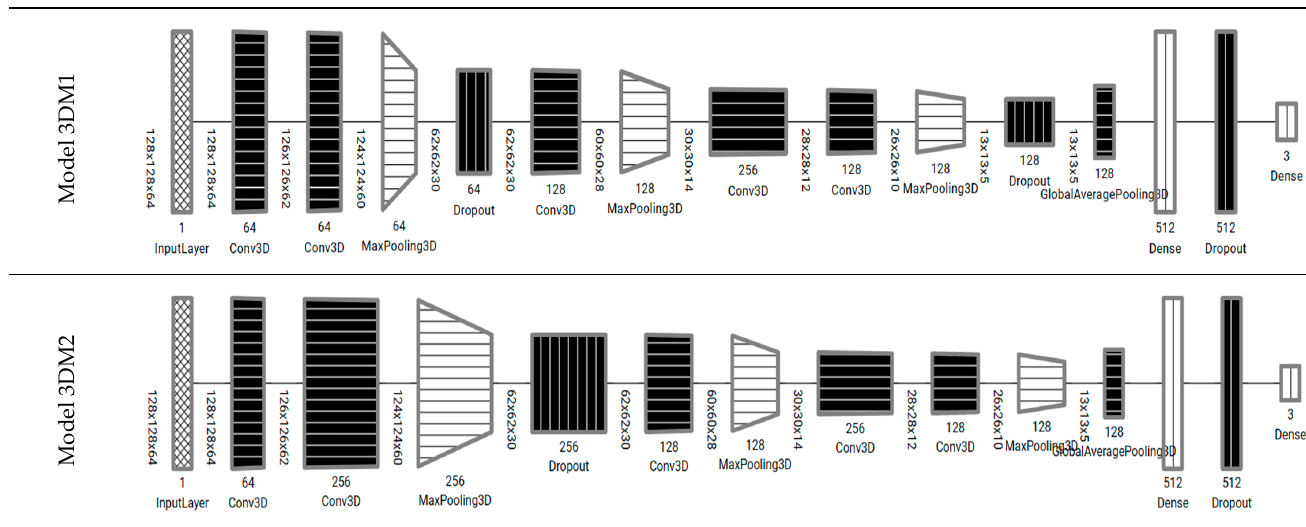
Table 4. Architectures of the 3D convolutional neural network Models 3DM1 and 3DM2, visualized using the tool by A. Bäuerle et al. [32].